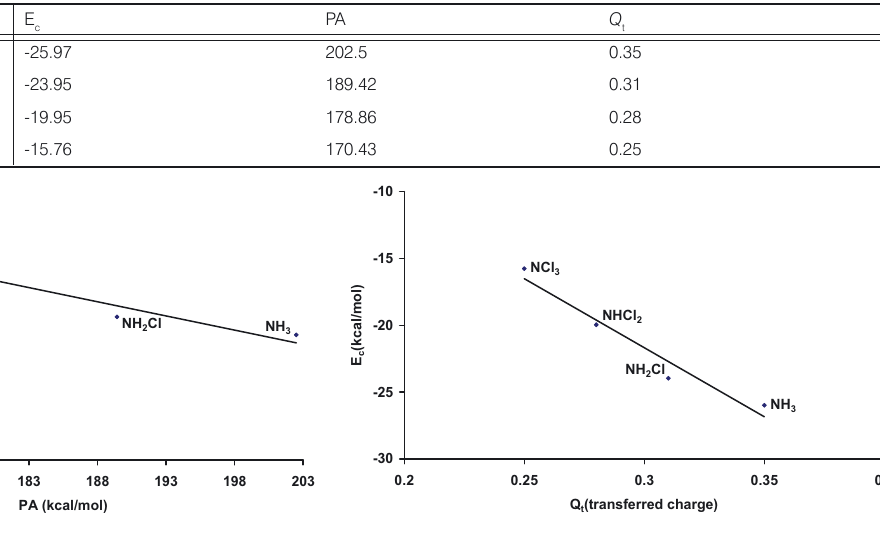
Figure 1. Linear correlation between G2(MP2) calculated proton